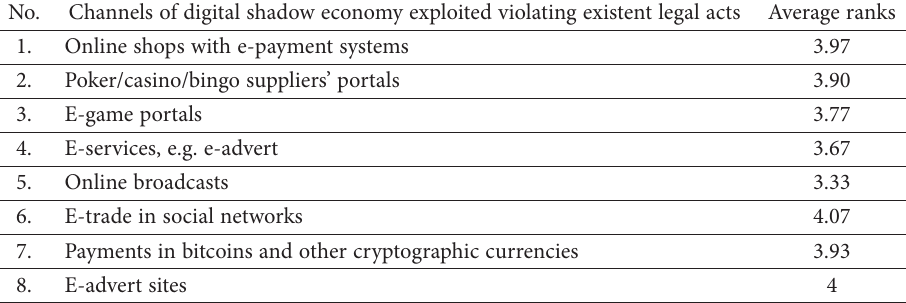
Table 6. Average ranks for the channels of digital shadow